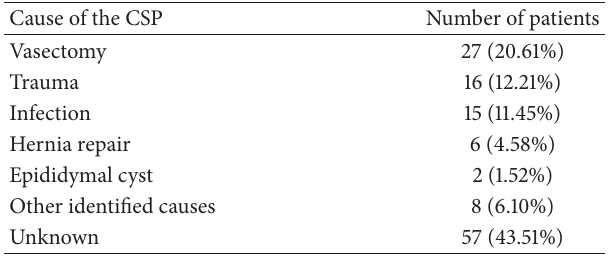
Table 1: Identified causes of the CSP.